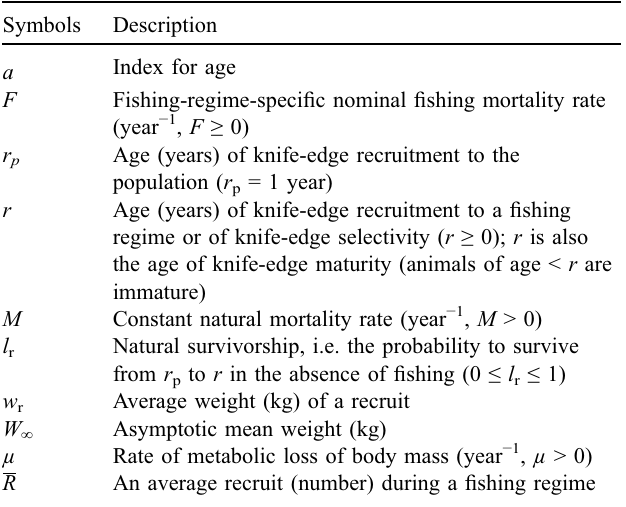
Table 1. Notations used in the CYPR14